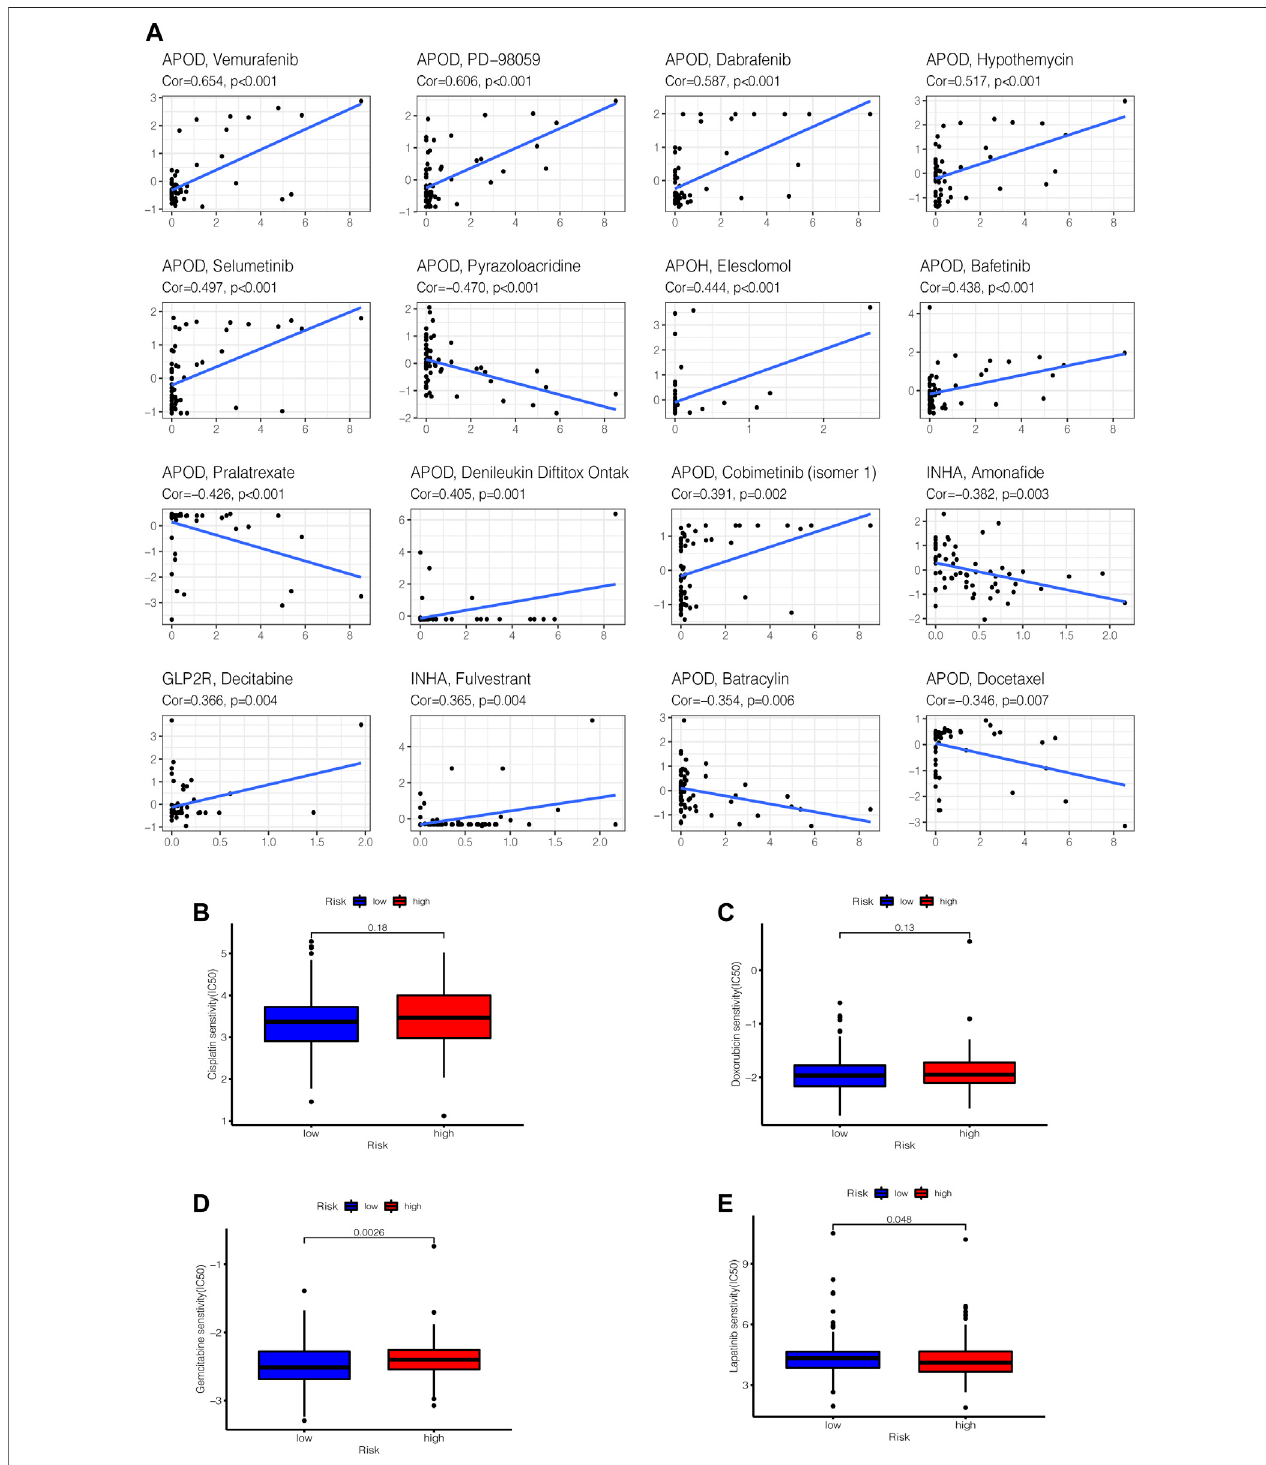
FIGURE 12 | Gene – drug sensitivity analysis. (A) based on the CellMiner database, the top 16 strongest correlations are shown. (B – E) Used the “ pRRophetic ” R package to compare differences in drug susceptibility between high and low risk groups, the drug sensitivity of (B) Cisplatin, (C) Doxorubicin, (D) Gemcitabine, (E) Lapatinib in high and low risk groups, respectively